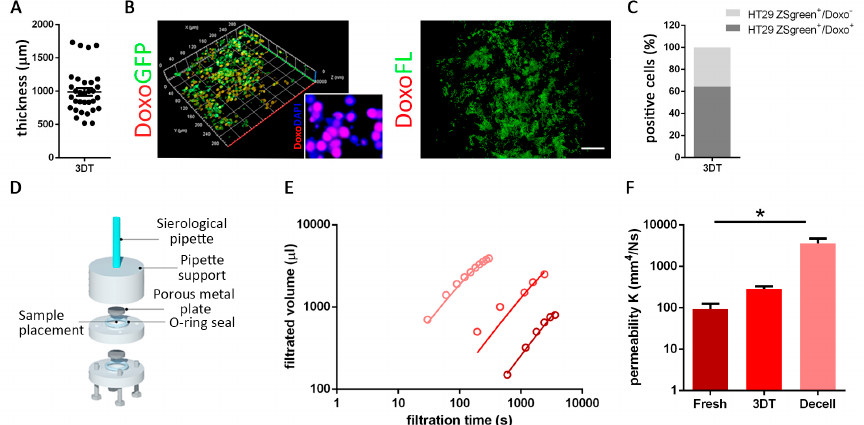
Figure 4. Drug di ff usion evaluation. ( A ) Thickness ( µ m) of a 3DT. ( B ) Doxorubicin (doxo; red) di ff usion assay in 3DT, repopulated with HT29 ZSgreen positive cells (green). In the enlargement, the same fixed samples were evaluated with immunofluorescence to underline the co-localization between drug (doxo) and nuclei (DAPI). Absence of non-specific binding between doxo and extracellular matrix (ECM) (scale bar = 100 µ m). ( C ) Quantification of co-localized signals. ( D ) In-house developed permeability device. ( E ) Experimental results of the filtration process carried out on the tumor colon fresh, 3DT, and decellularized (decell). Open circles refer to the experimental values, and solid black lines to the Equation (2) fitted to experimental data, and the charts report the estimated values of permeability K (mm4 / Ns). ( F ) Quantification of permeability measurement obtained from fresh, 3DT, and decellularized (decell) tumor samples. (* p -value < 0.05; ** p -value < 0.01; *** p -value <